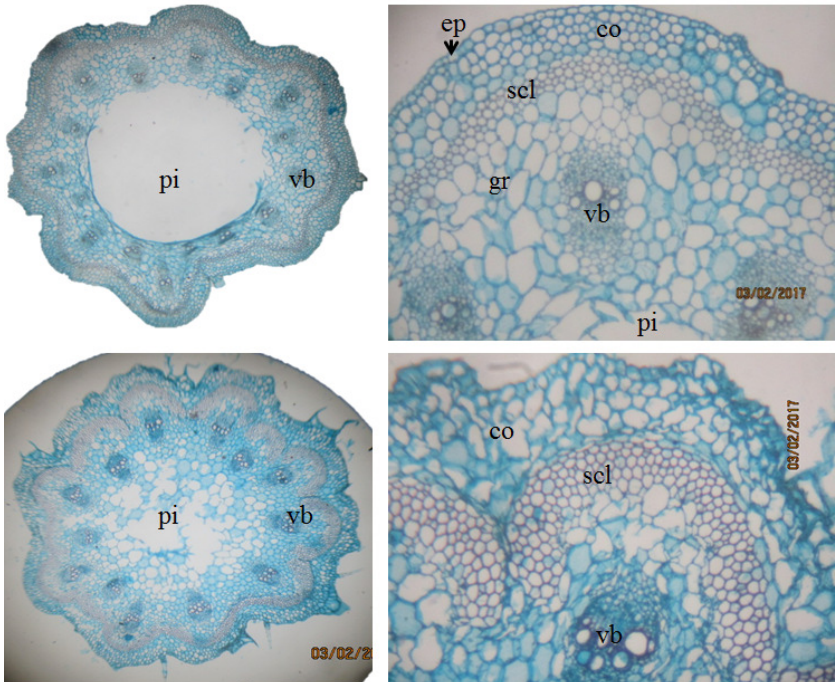
Fig. 7. Anatomy of flower stalks of B. hispida (A and B) = male flower and (C and D) = female flower (pi = pith, vb = vacular bundle, scl = sclerenchymatous cells, co = cortex, ep = epidermal cell, gr = ground tissue) Stem